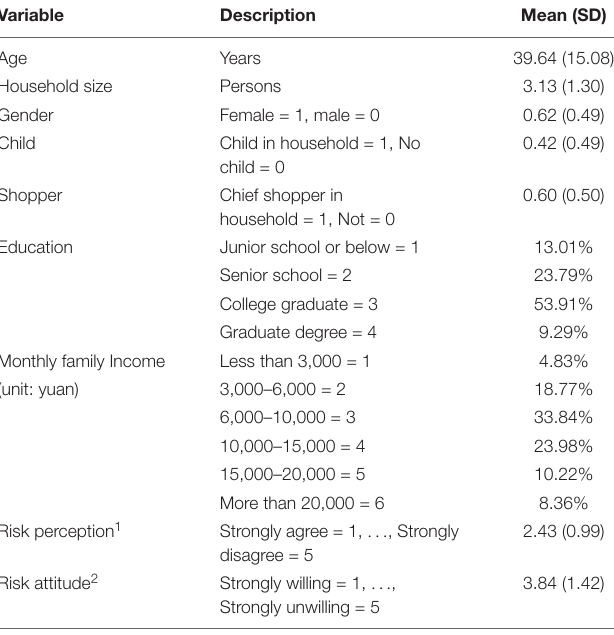
TABLE 2 | Socio-demographic